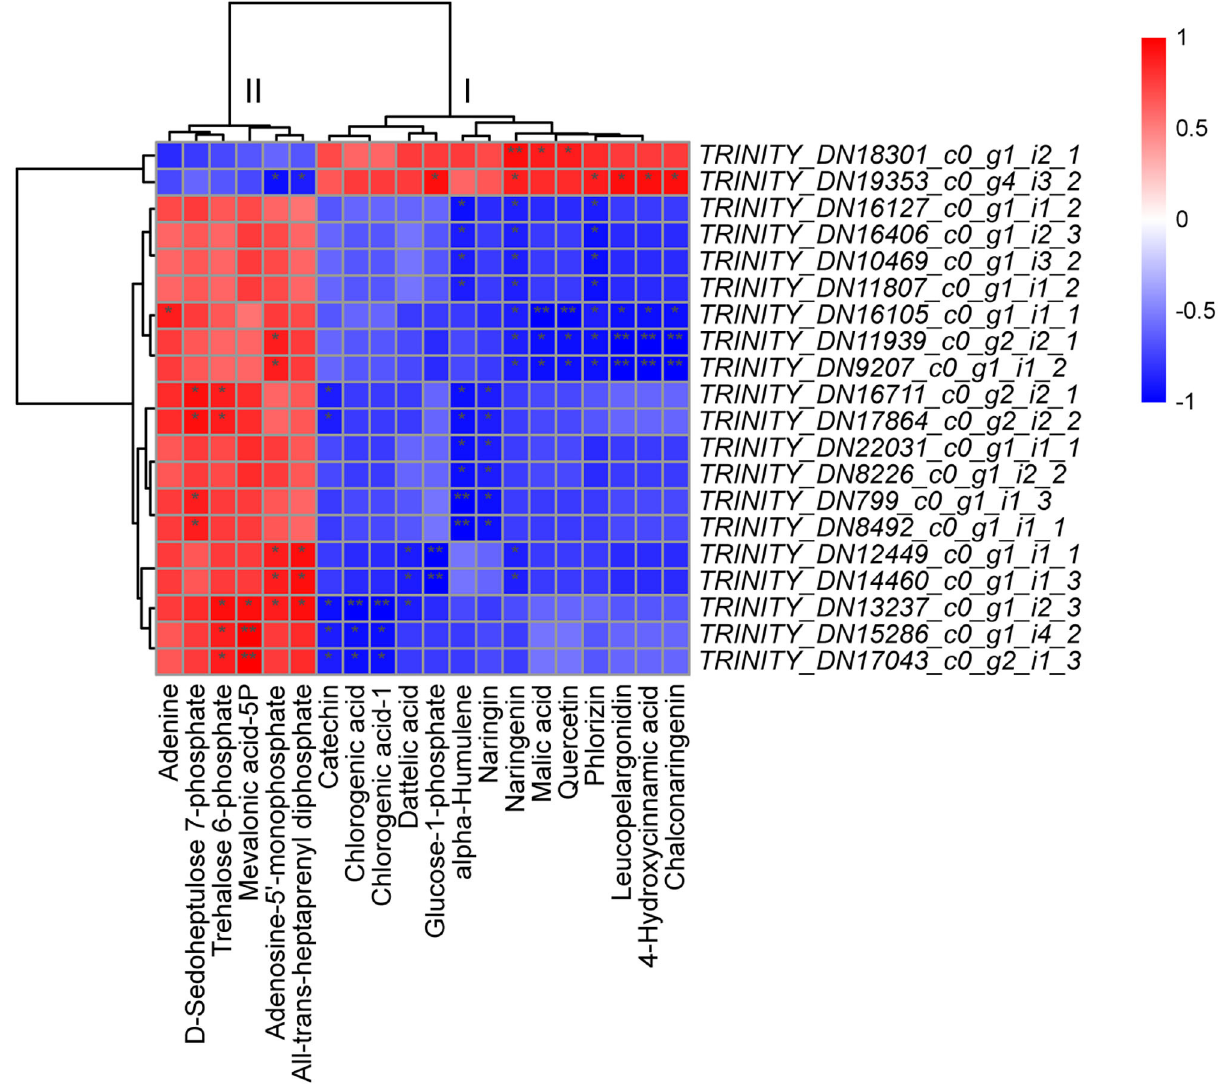
FIGURE 5 | Correlation analysis of the top 20 differentially expressed unigenes (DEGs) and differentially synthesized metabolites (DSMs). Red/blue indicates a positive/negative correlation, and a deeper color indicates stronger correlations; among them, * represents a significant correlation ( p ≥ 0.5 or p ≤ – 0.5). ** represents a very significant correlation ( p = 1.0 or